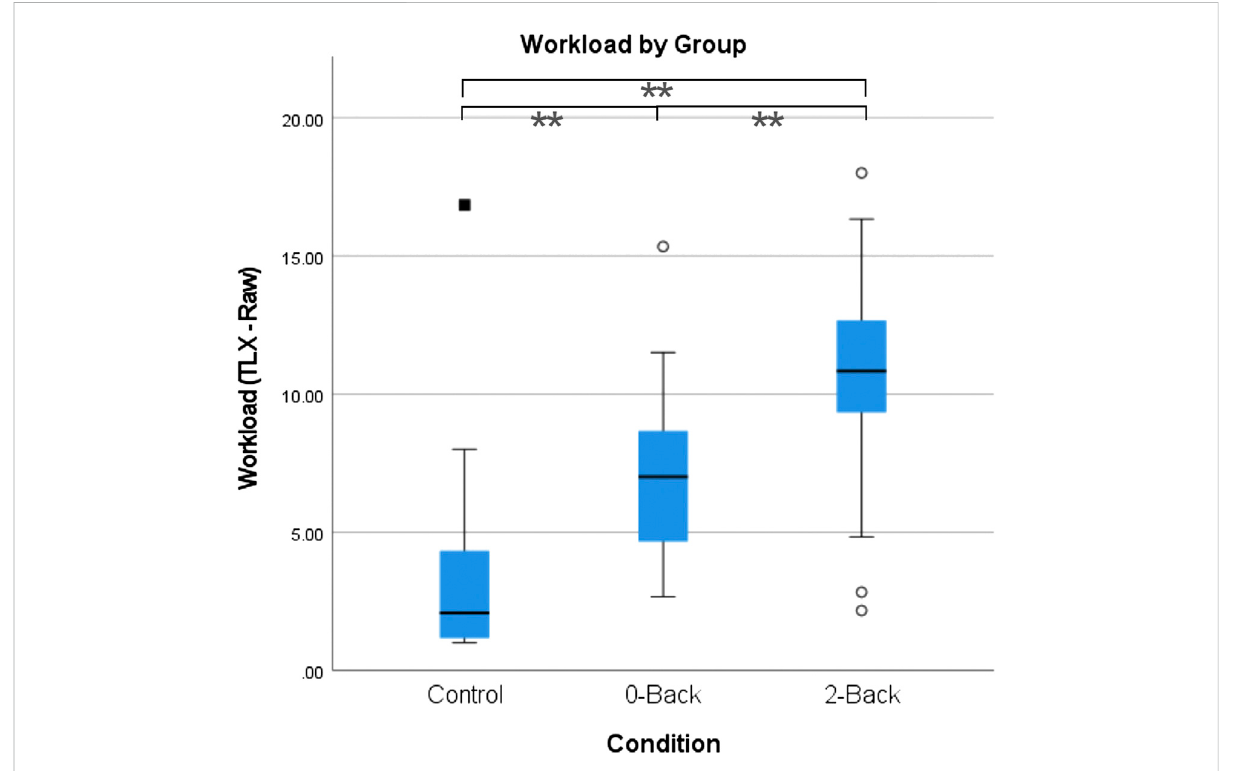
FIGURE 7 Workload by Group boxplots. ** = signi fi cant difference at a p < 0.01